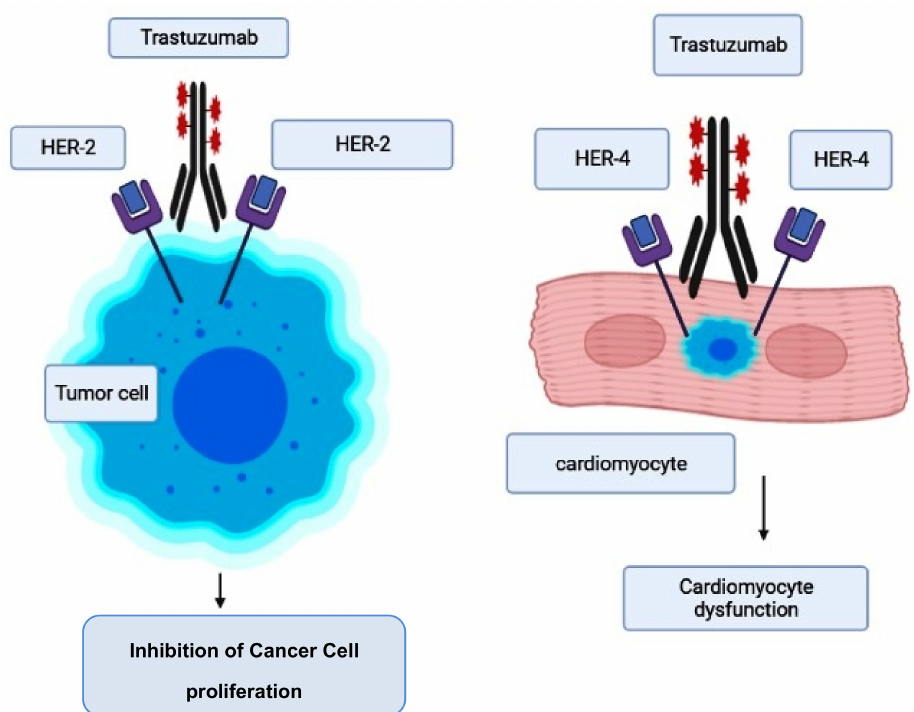
Figure 2. Mode of action of trastuzumab and its cardiotoxicity